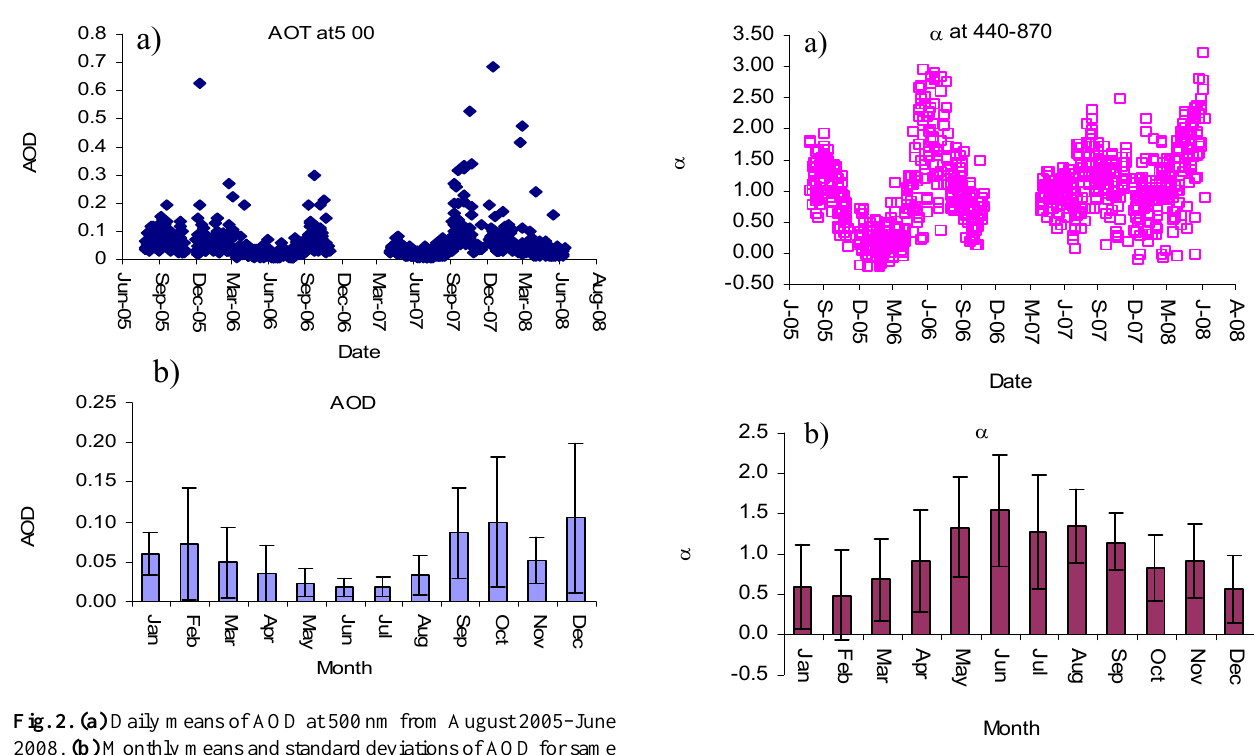
2008. (b) Monthly means and standard deviations of α for same